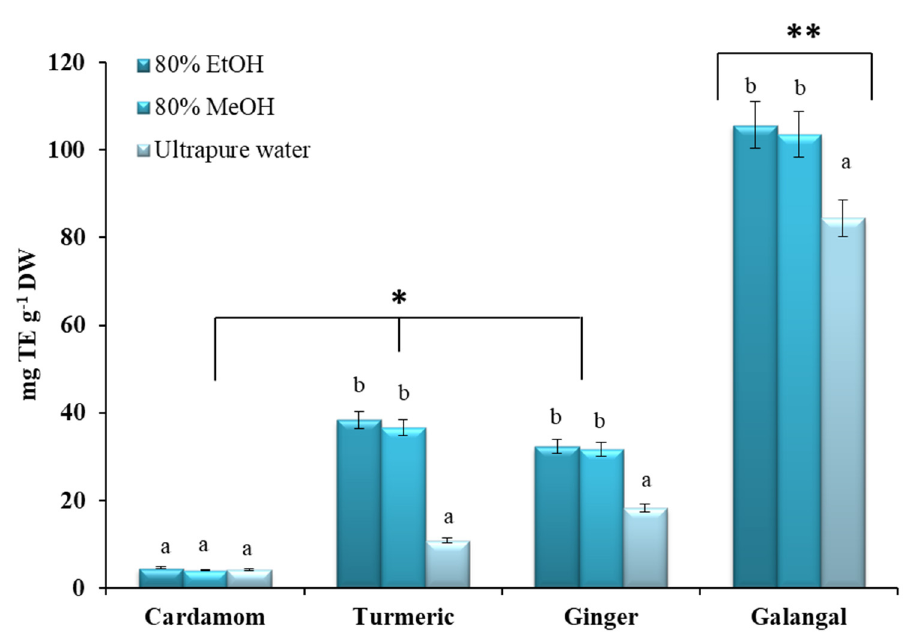
Figure 5. Antioxidant activity of selected Zingiberaceae species expressed as mg trolox equivalents per gram of dry weight (mg TE g − 1 DW). All measurements were performed in duplicate. For comparison of the mean values, one-way ANOVA followed by S-N-K post hoc were applied. A different superscript letters (a, b) indicate a statistical difference in the extraction efficiencies of the solvents tested ( p < 0.05), while asterisks indicate statistical differences in antioxidant activity between different plants ( p < 0.05).